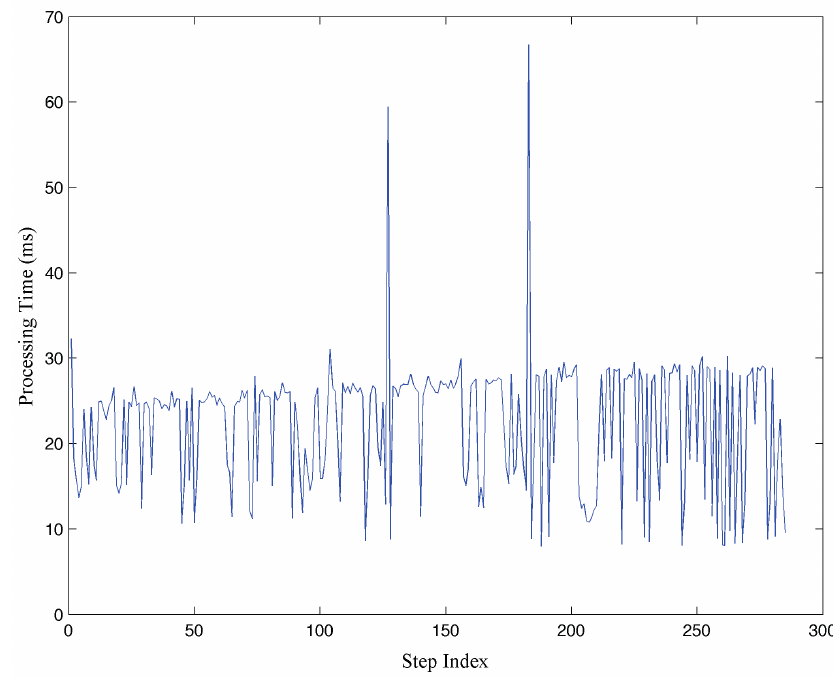
Figure 13. Example processing time of individual